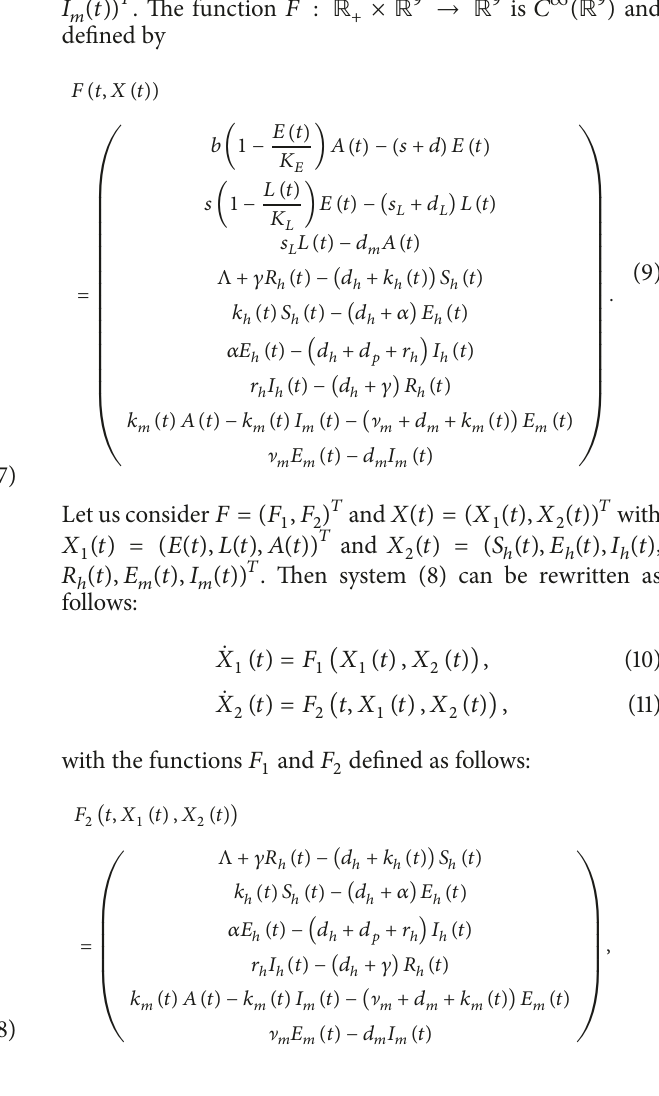
Using (2), we get 𝑆 𝑚 (𝑡) = 𝐴(𝑡) − 𝐸 𝑚 (𝑡) − 𝐼 𝑚 (𝑡) and then the where 𝑋(𝑡) = (𝐸(𝑡), 𝐿(𝑡), 𝐴(𝑡), 𝑆 ℎ (𝑡), 𝐸 ℎ (𝑡), 𝐼 ℎ (𝑡), 𝑅 ℎ (𝑡), 𝐸 𝑚 (𝑡) ,